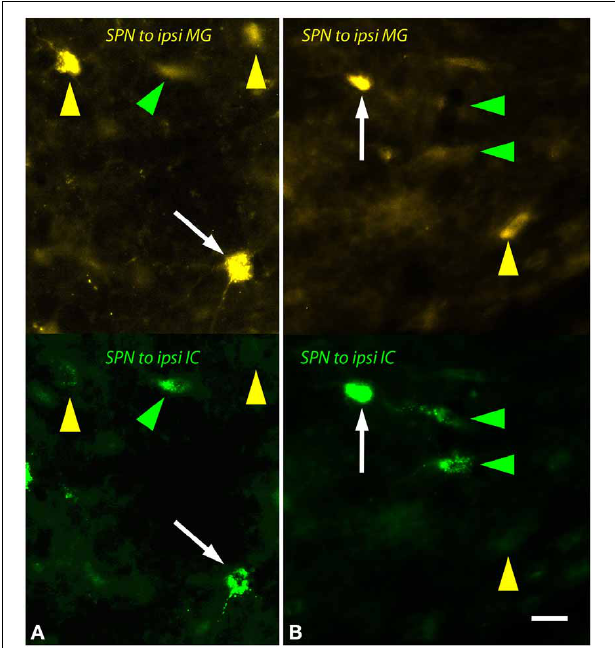
FIGURE 6 | Photomicrographs showing labeled cells in the left superior paraolivary nucleus (SPN) after injections into the medial geniculate nucleus (MG) and the inferior colliculus (IC). Each panel shows FluoroGold (upper half) and green beads (lower half). (A,B) Double-labeled cells are numerous (white arrows). Additional cells contained only FluoroGold (yellow arrows) or only green beads (green arrowheads). Transverse sections; dorsal is up; lateral is to the left. Scale bar = 20 µ m. ipsi,